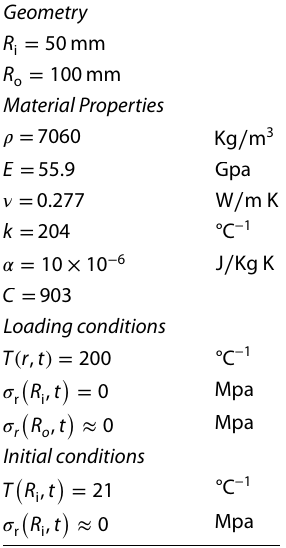
Table 1 Material and geometrical properties